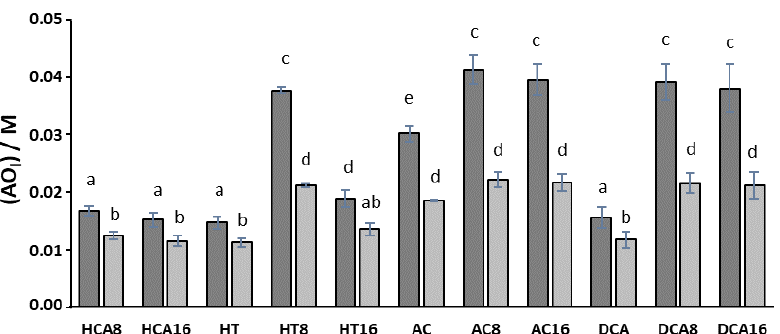
Figure 3. Effective concentration of AO in the interfacial region of 4:6 (O/W) emulsions (olive oil/citrate buffer, 0.04M, pH = 3.65/Tween 20) for the emulsifier fractions of Φ I = 0.005 (dark grey color) and Φ I = 0.01 (light gray color), [AO T ] = 0.24 mM. Different letters (superscripts) indicate samples that were significantly different ( p < 0.05).